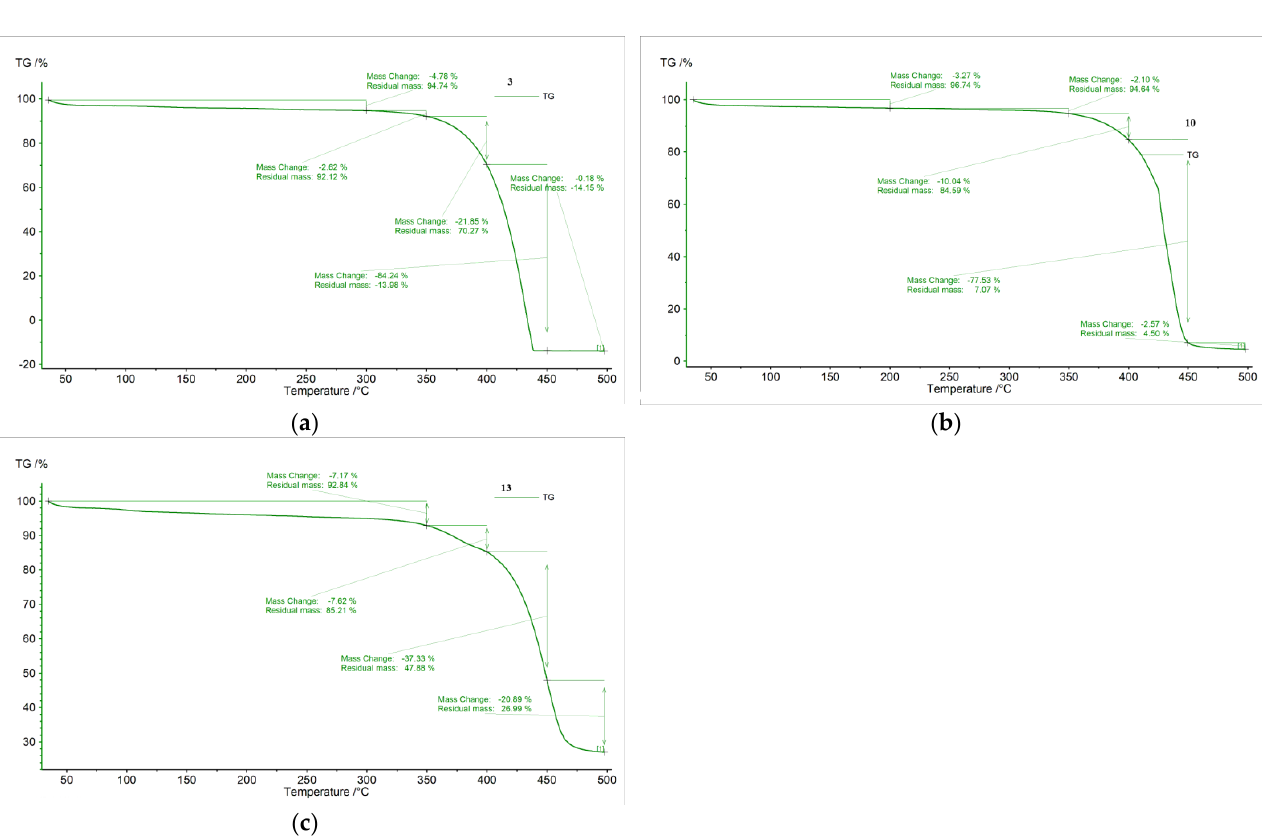
Figure 2. Thermogravimetric analysis of the complexes 3 ( a ), 10 ( b ) and 13 ( c ).